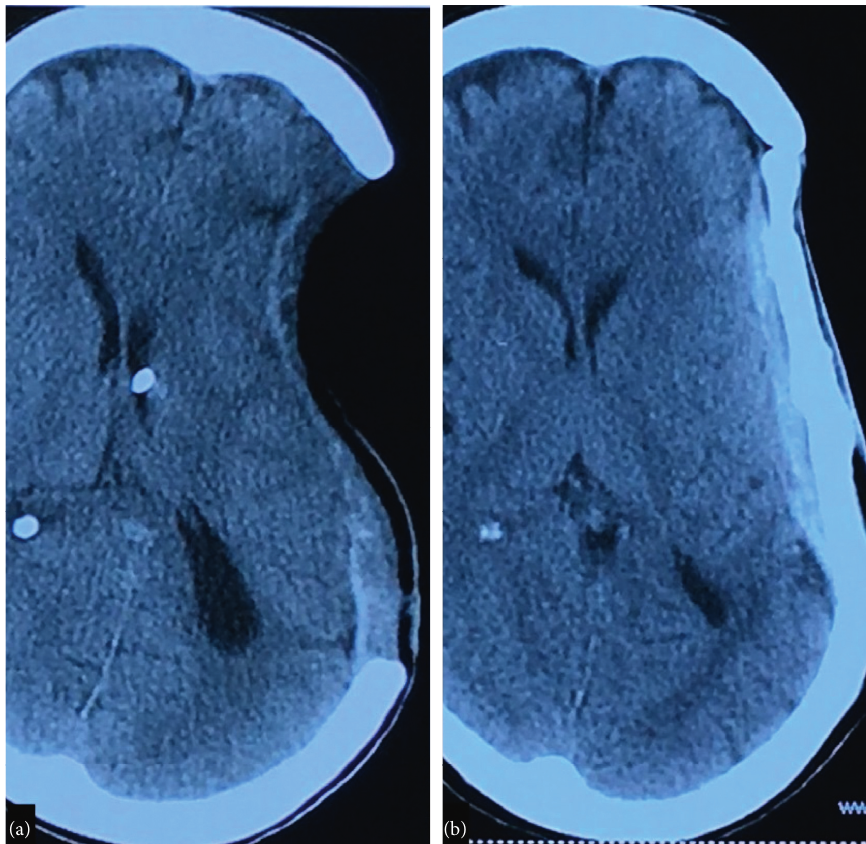
Figure 3: (a) Computed tomography (CT) plain brain, axial view showing VP shunt in situ and excessively sunken brain at craniectomy site causing midline shift to the right side. (b) Computed tomography (CT) plain brain, axial view on postoperative day 1, showing cranioplasty using flattened bone. Also, partial resolution of midline shift can be